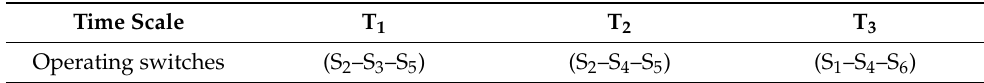
Table 1. Switching operation in various time